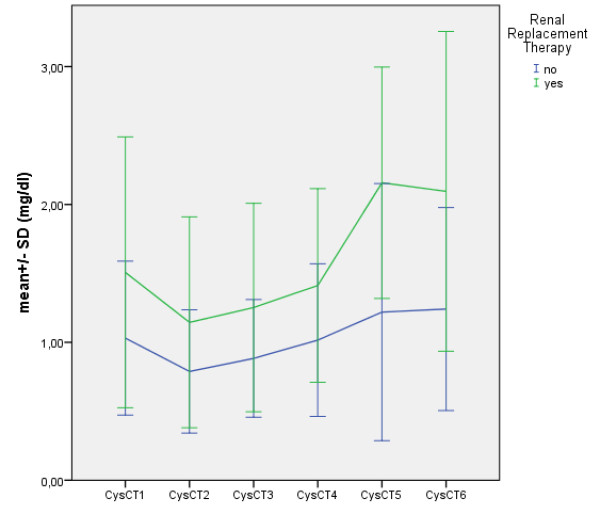
Shows the longitudinal differences between time (t1-t6) and the measured CysC values in patients with and without postoperative renal replacement therapy.